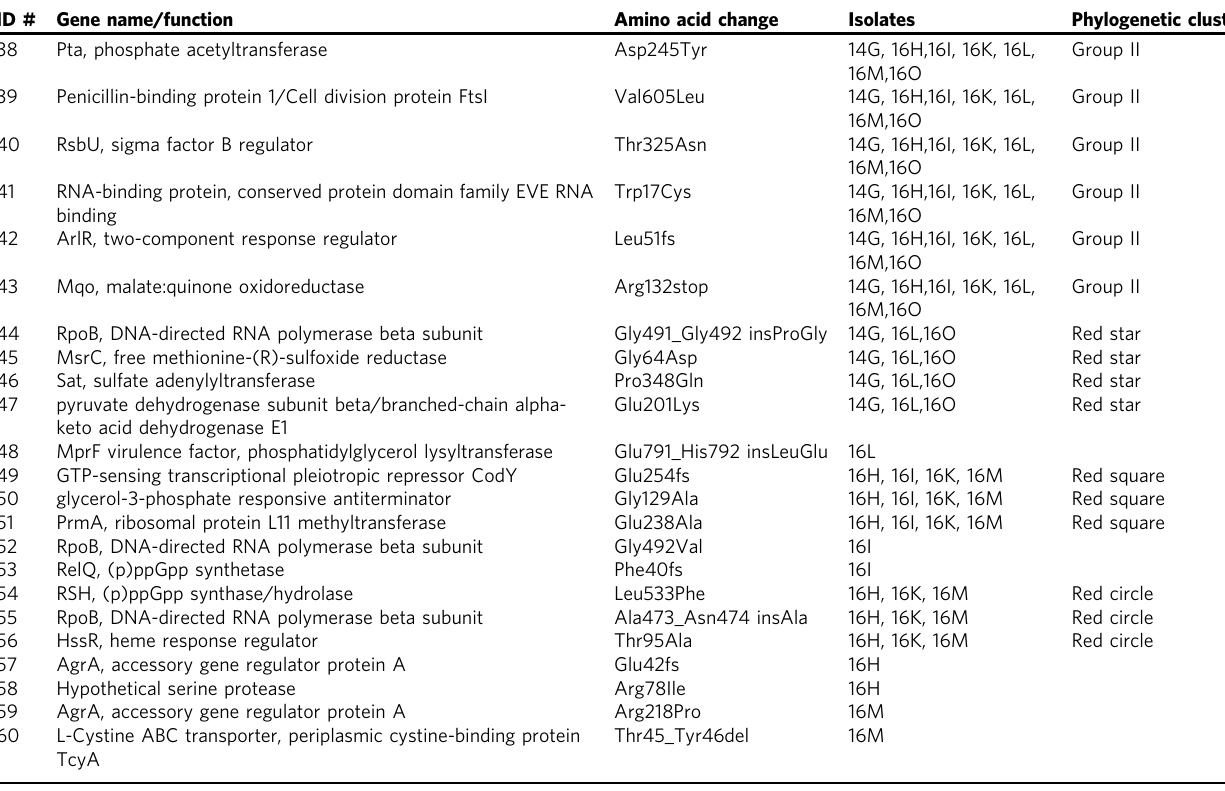
Table 3 Non-synonymous SNPs and InDels found in the group II clinical ST378 S. epidermidis